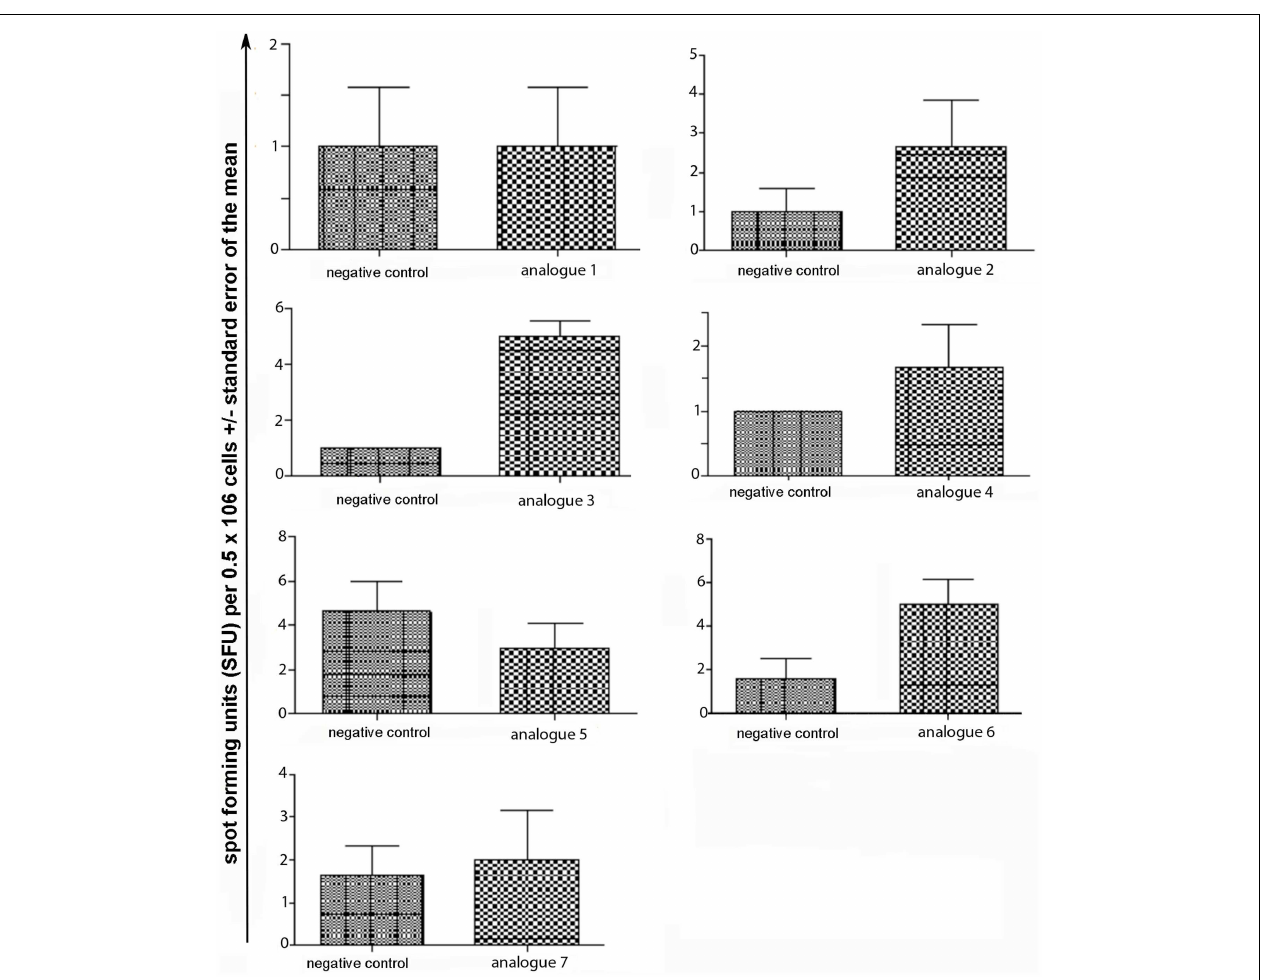
conjugated to reduced mannan via KLH linker (analogs 6 and 7 ). No peptide (cells alone) was used as background negative control. ConA was used as an internal positive control to ensure cells were reactive, not